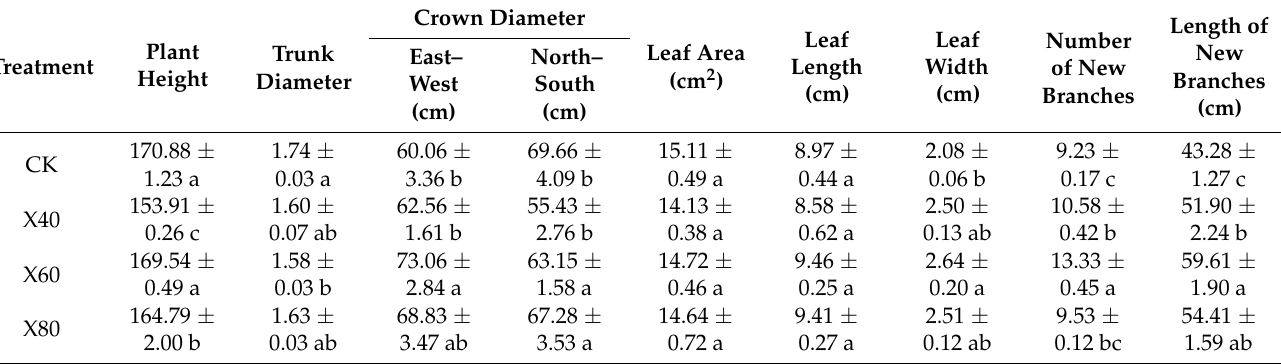
Table 1. Growth parameters of L. barbarum trees cultivated under different root-restriction treatments and under no root-restriction cultivation (CK) (mean ±